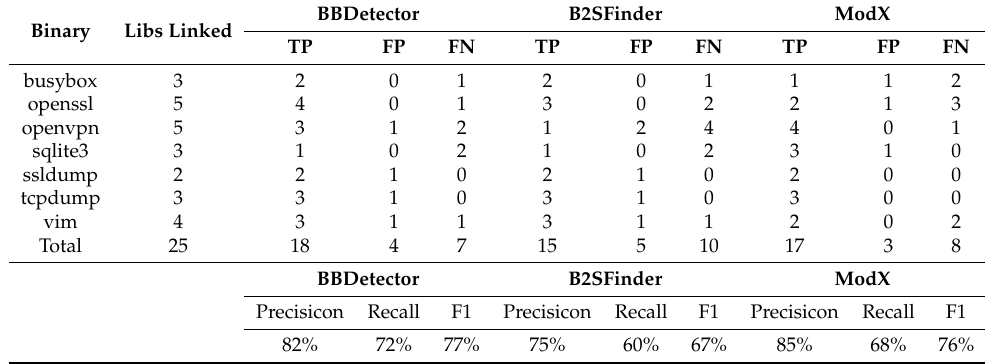
Table 4. TPL Detection on ubuntu binary dataset.